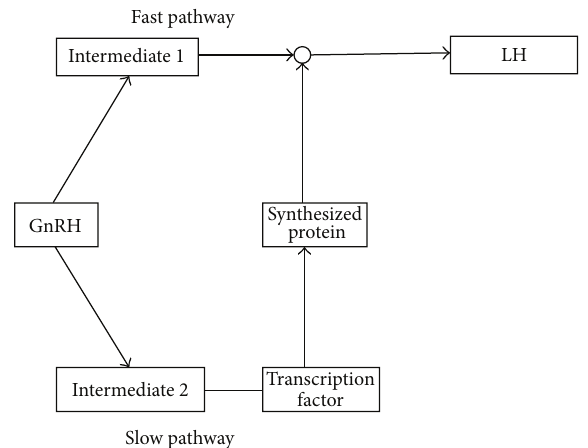
Figure 1: The elements of the interaction model. GnRH activates two pathways in this model, which synergize to produce an aug- mented LH